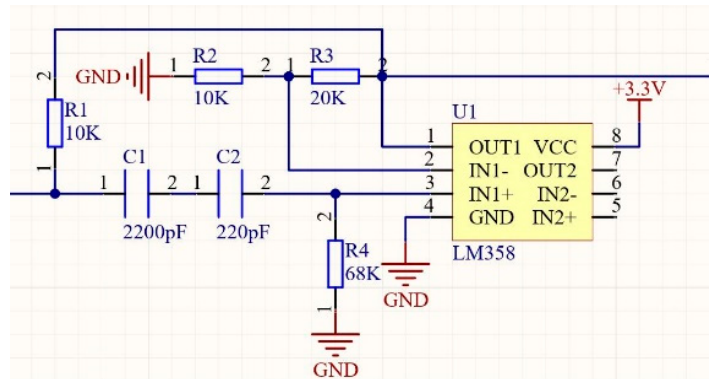
Figure 7. Two-order high-pass filtration circuit with a cutoff frequency of 8.7 kHz.